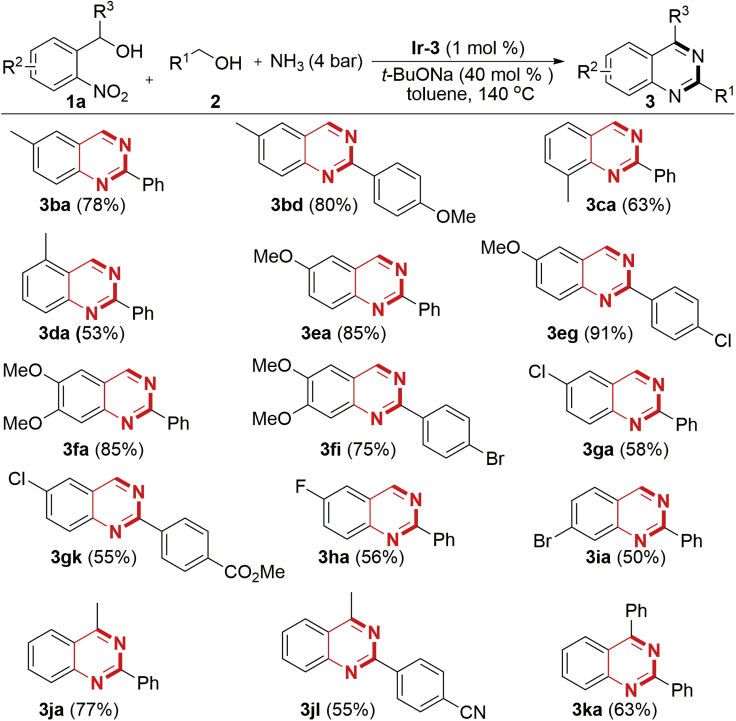
Variation of o-Nitroaryl AlcoholsAlso see Scheme S1, Figures S61−S91 and Data S3.